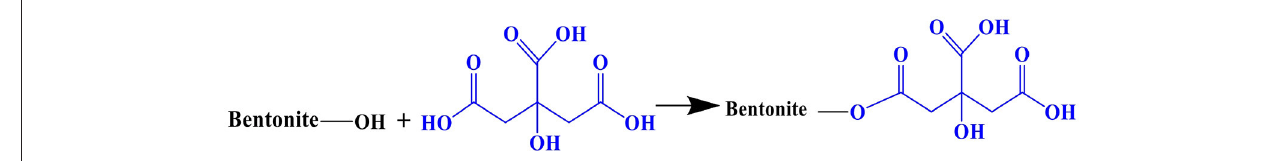
FIGURE 9 | Esterification reaction of bentonite and critic acid.